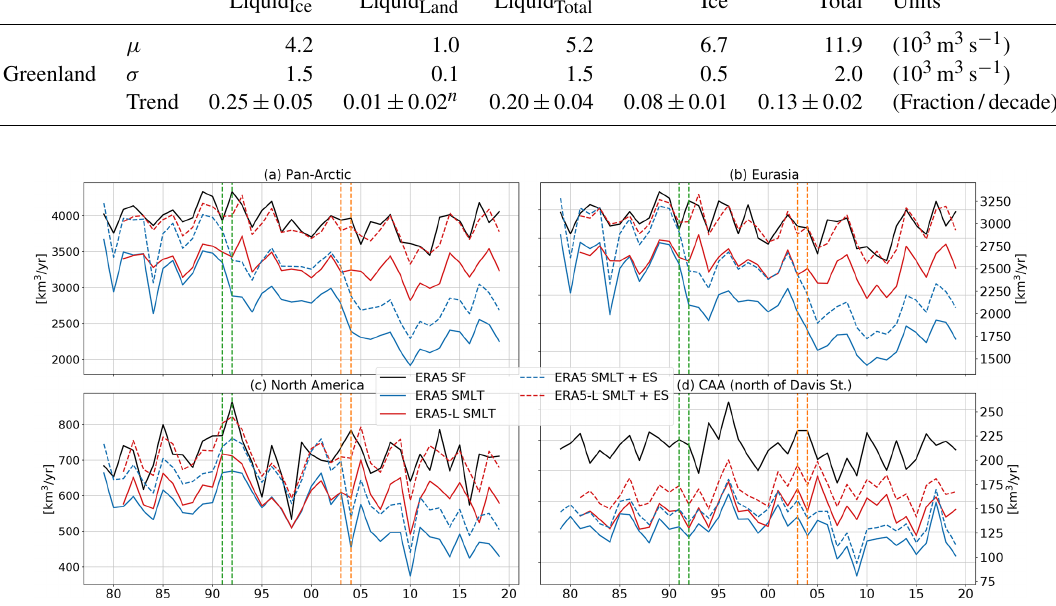
Figure 7. Annual means of ERA5 snowfall (SF, black; 1979–2019), ERA5 SMLT (blue; 1979–2019) and the sum of ERA5 snowmelt and snow evaporation (SMLT + ES, blue dashed; 1979–2019) as well as ERA5-Land snowmelt (red; 1981–2019) and ERA5-Land SMLT + ES (red, dashed; 1981–2019) for the whole pan-Arctic region (a) , Eurasia (b) , North America (c) , and the CAA (d) . Vertical lines show the position of the snowmelt discontinuities in 1992 (green) and 2004